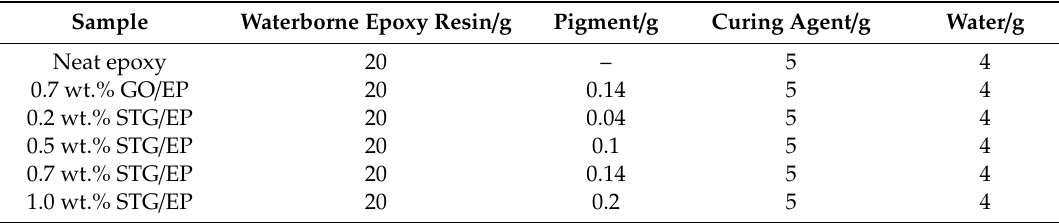
Table 1. Formulations of coatings.